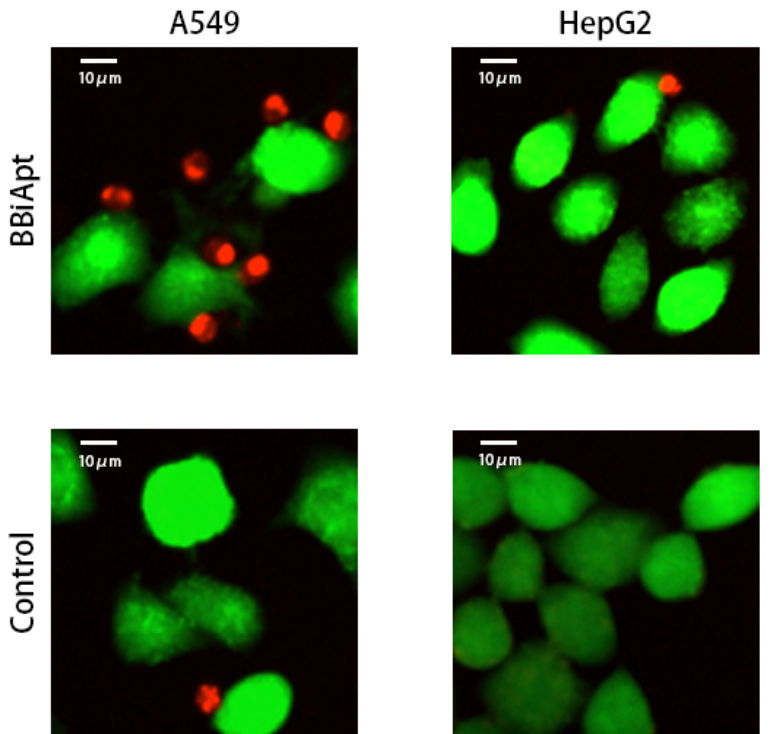
Figure 6. Recruitment of immunocytes to target cells in the presence or absence of BBiApt. Live MUC1-positive A549 cells or MUC1-negative HepG2 cells were stained green with CFSE, while live PBMCs were stained red with eFluro670. Tumor cells and PBMCs were mixed together, with or without BBiApt. After washing thrice, the remaining cells were observed with laser scanning confocal microscope.